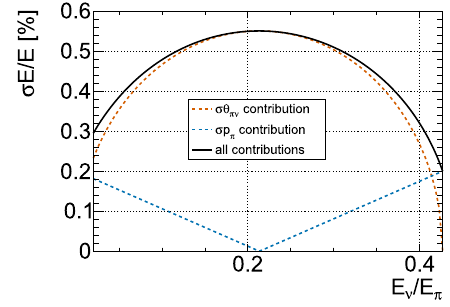
Fig. 5 Energy resolution on the tagged neutrino as a function of the fraction of the π ± energy transferred to the ν (black solid) overlaid with the contributions from the resolutions on the angle between the π ± and ν (red dashed) and on the π ± momentum (blue